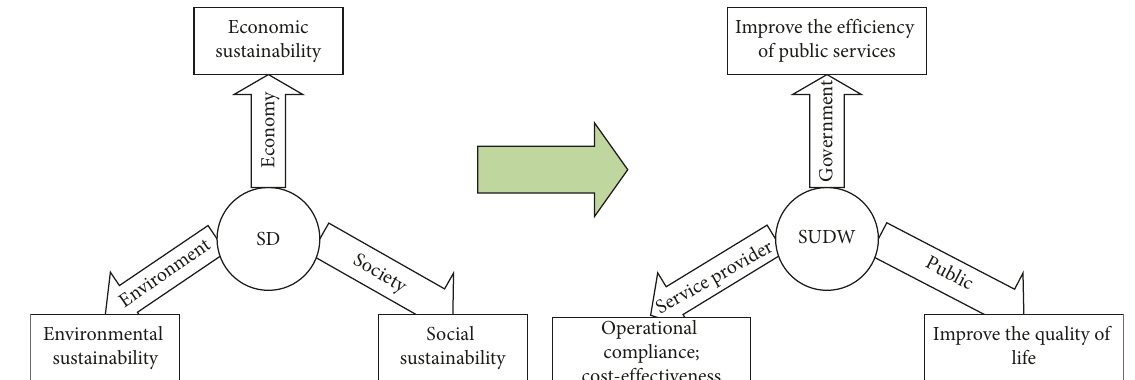
Figure 3: Objectives of SUDW (SD � sustainable development).